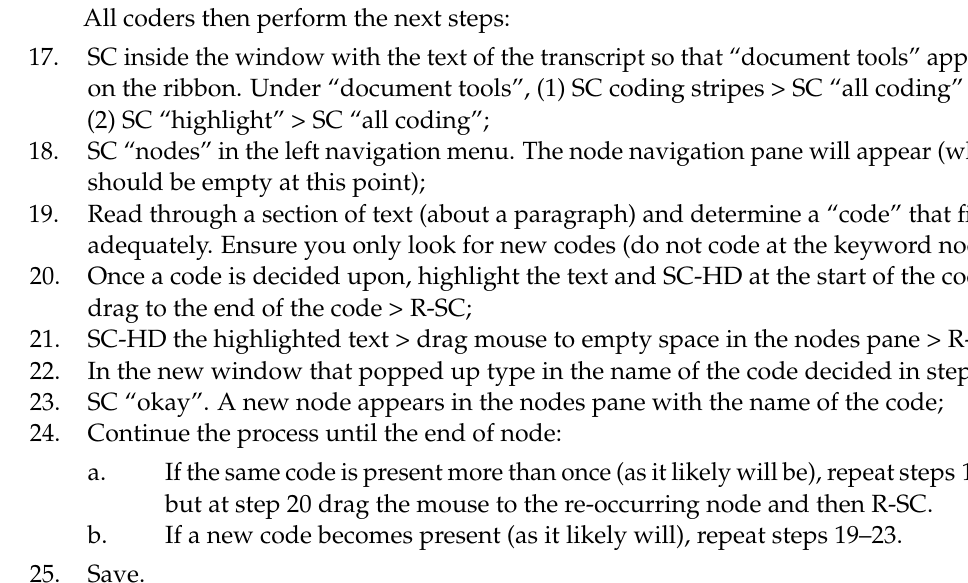
Figure 3. Open coding steps with the entire interview method screenshot (Steps 1–5).